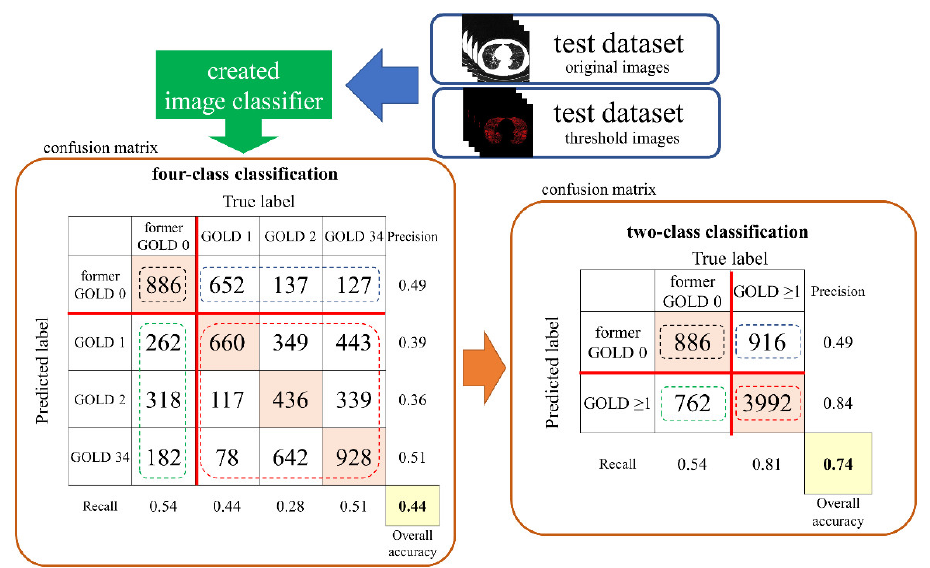
Figure 1. Schematic of the datasets and subsets for training and test.